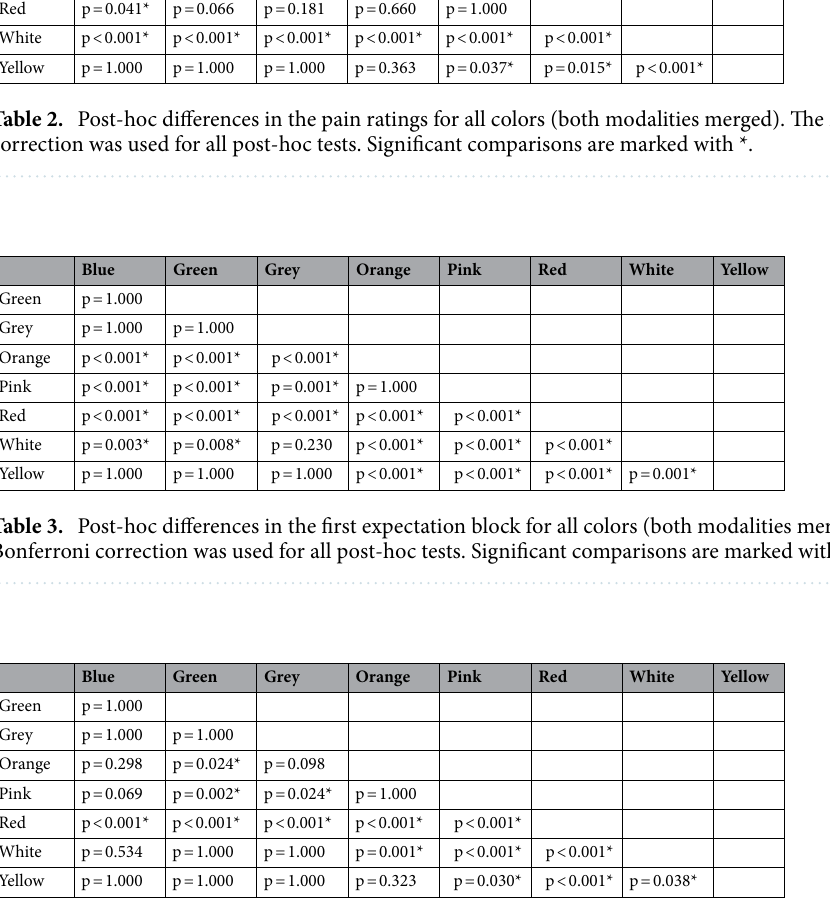
Table 4. Post-hoc differences in the second expectation block for all colors (both modalities merged). The Bonferroni correction was used for all post-hoc tests. Significant comparisons are marked with *.